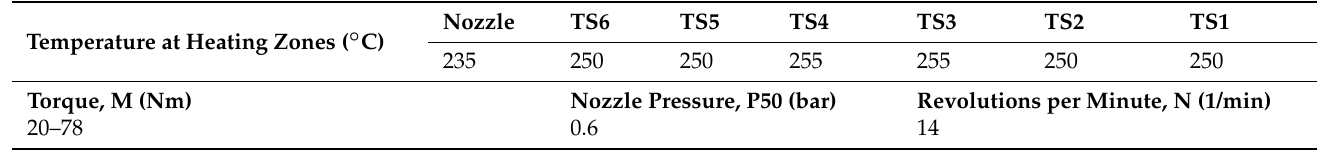
Table 1. Extrusion